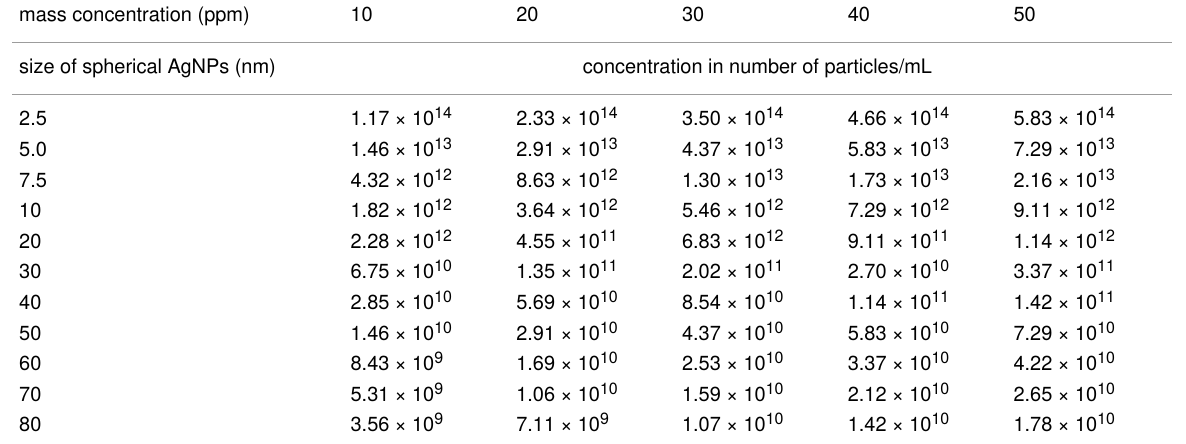
Table 5: Conversion table from mass concentration (mg/L) to concentration in number of particles/mL depending on the size of the spherical AgNPs. mass concentration (ppm)